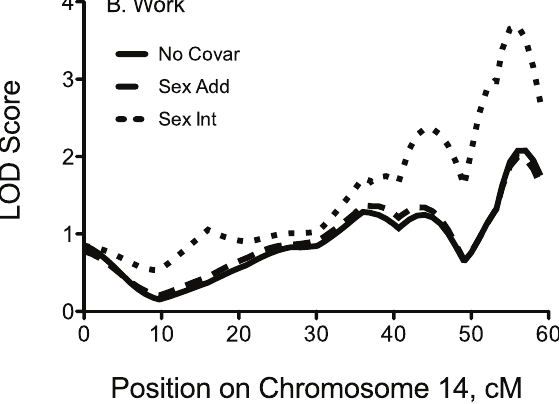
Figure 4. QTL analyses for the effect of sex on intrinsic exercise capacity in male and female (B6.A14 × B6) F mice expressed as 2 time ( A ) and work ( B ). Single chromosome-wide scans for time (in min) and work (in kg·m) were performed separately on male and female F mice. Dashed lines in the upper graph represent the 2 suggestive (0.82, P = 0.63) and significant (2.21, P = 0.05) logarithm of odds (LOD) thresholds for time in males. Dashed lines in the lower graph represent the suggestive (0.82, P = 0.63) and significant (2.25, P = 0.05) LOD thresholds for work in males. In females, suggestive and significant LOD thresholds for time were 0.84 (P = 0.63) and 2.15 (P = 0.05), respectively; and for work 0.81 (P = 0.63) and 2.08 (P = 0.05), respectively. LOD thresholds were determined using